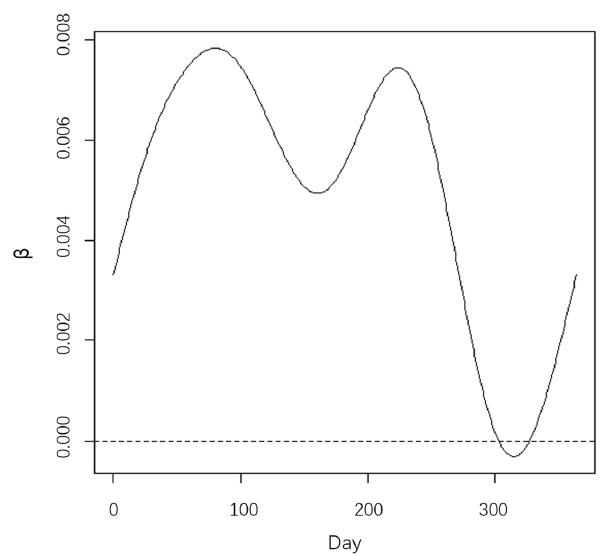
Figure 5. Regression parameter estimation without partitioning.